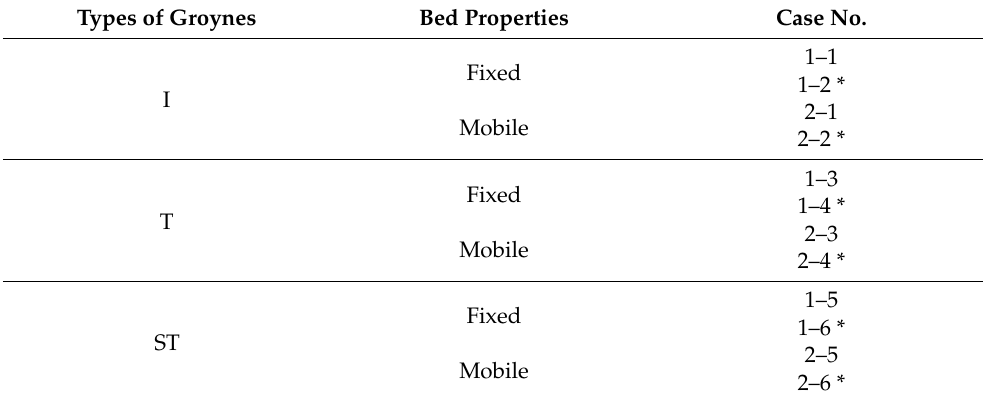
Table 1. Experimental Series.